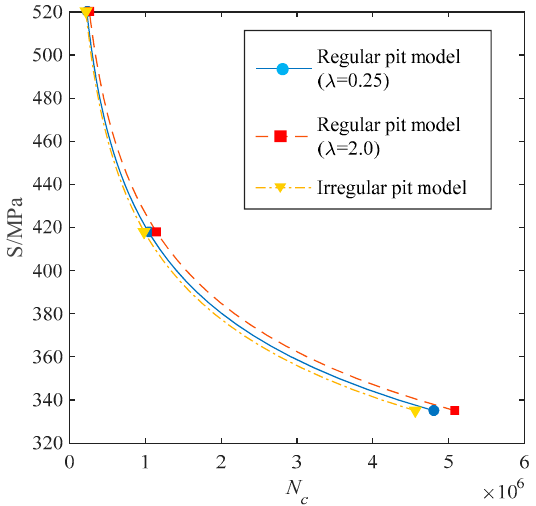
Figure 14. S-N curves of pre-corroded steel wire with mass loss rate of 0.25%.